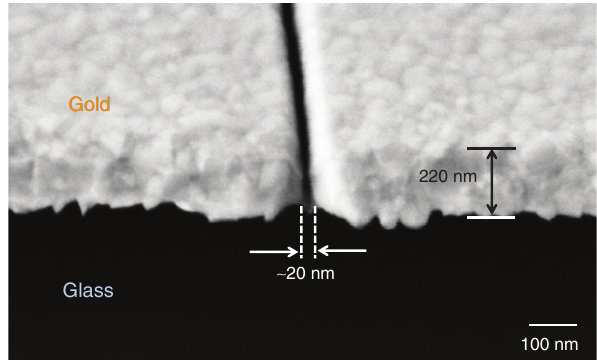
Figure 7: High-aspect ratio FIB cut [89]. SEM image of a 45 ° -tilted 20-nm-wide groove milled into a 220-nm- thick sputtered Au film on a glass substrate. The substrate was sliced to reveal the side view of the cross-section.